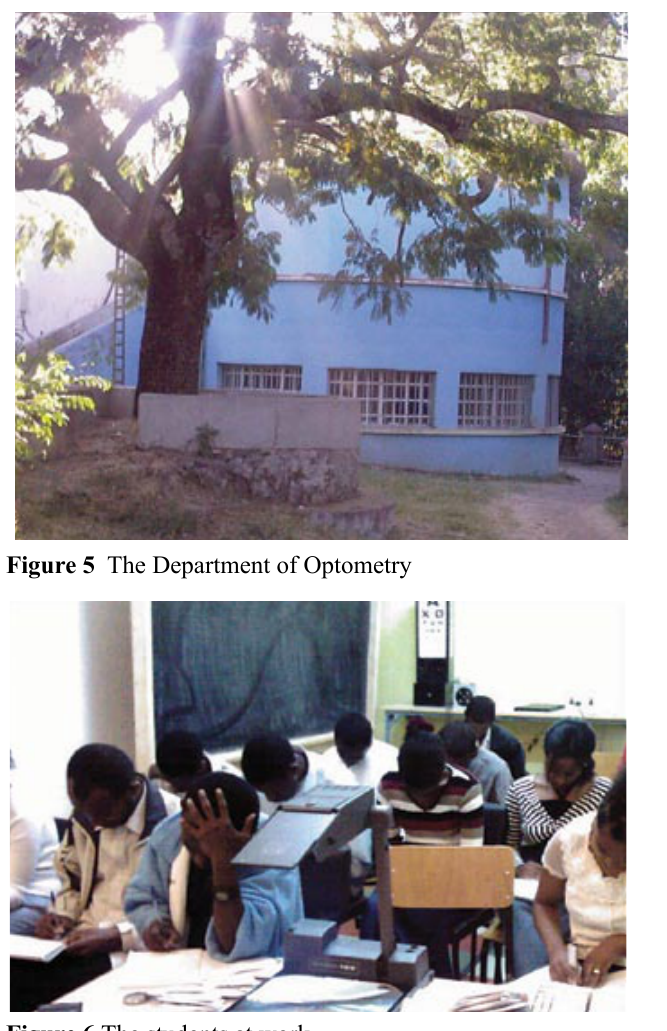
Figure 6 The students at work